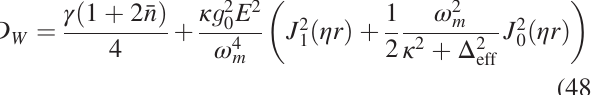
FIG. 4 (color online). Amplitude r 0 for the first stable limit cycle versus bare detuning Δ . In the limit of an amplitude- independent effective detuning (red lines), the values for large amplitudes are predicted correctly. It is known from Ref. [19] that for small amplitudes at the onset of limit cycles, the amplitude follows a square root (red lines). With the inclusion of the r Þ (blue line), the limit-cycle dynamical effective detuning Δ ffiffiffiffiffiffiffiffiffiffiffiffiffi p eff ð , both limit cases amplitude r 0 follows J 0 ð η r 0 Þ ¼ are reproduced, and the whole transition between the regimes of damping and antidamping can be described. In this figure, we compare the predictions with the numerical solution (dots) of the classical equation. The parameters of this plot are ð E; g 0 ; κ E ¼ 2 κ ; γ Þ ¼ ð 0 . 5 ; 0 . 25 ; 0 . 3 ; 0 . 0 Þ × ω m